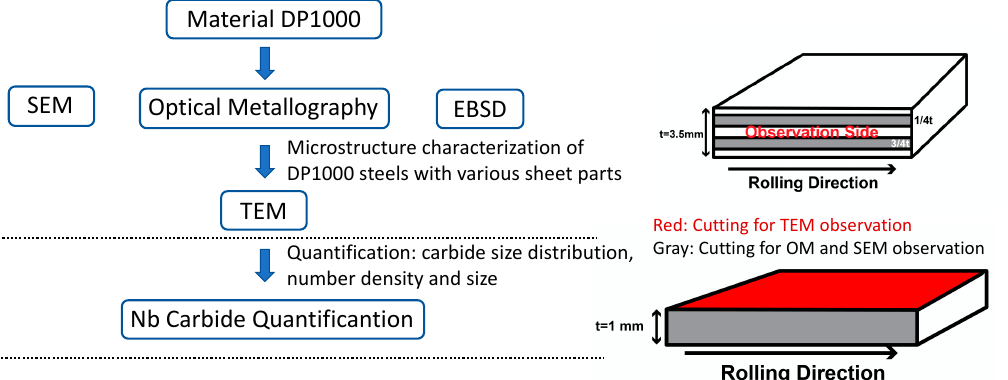
Figure 2. Methods and sample preparation for microstructural characterization.